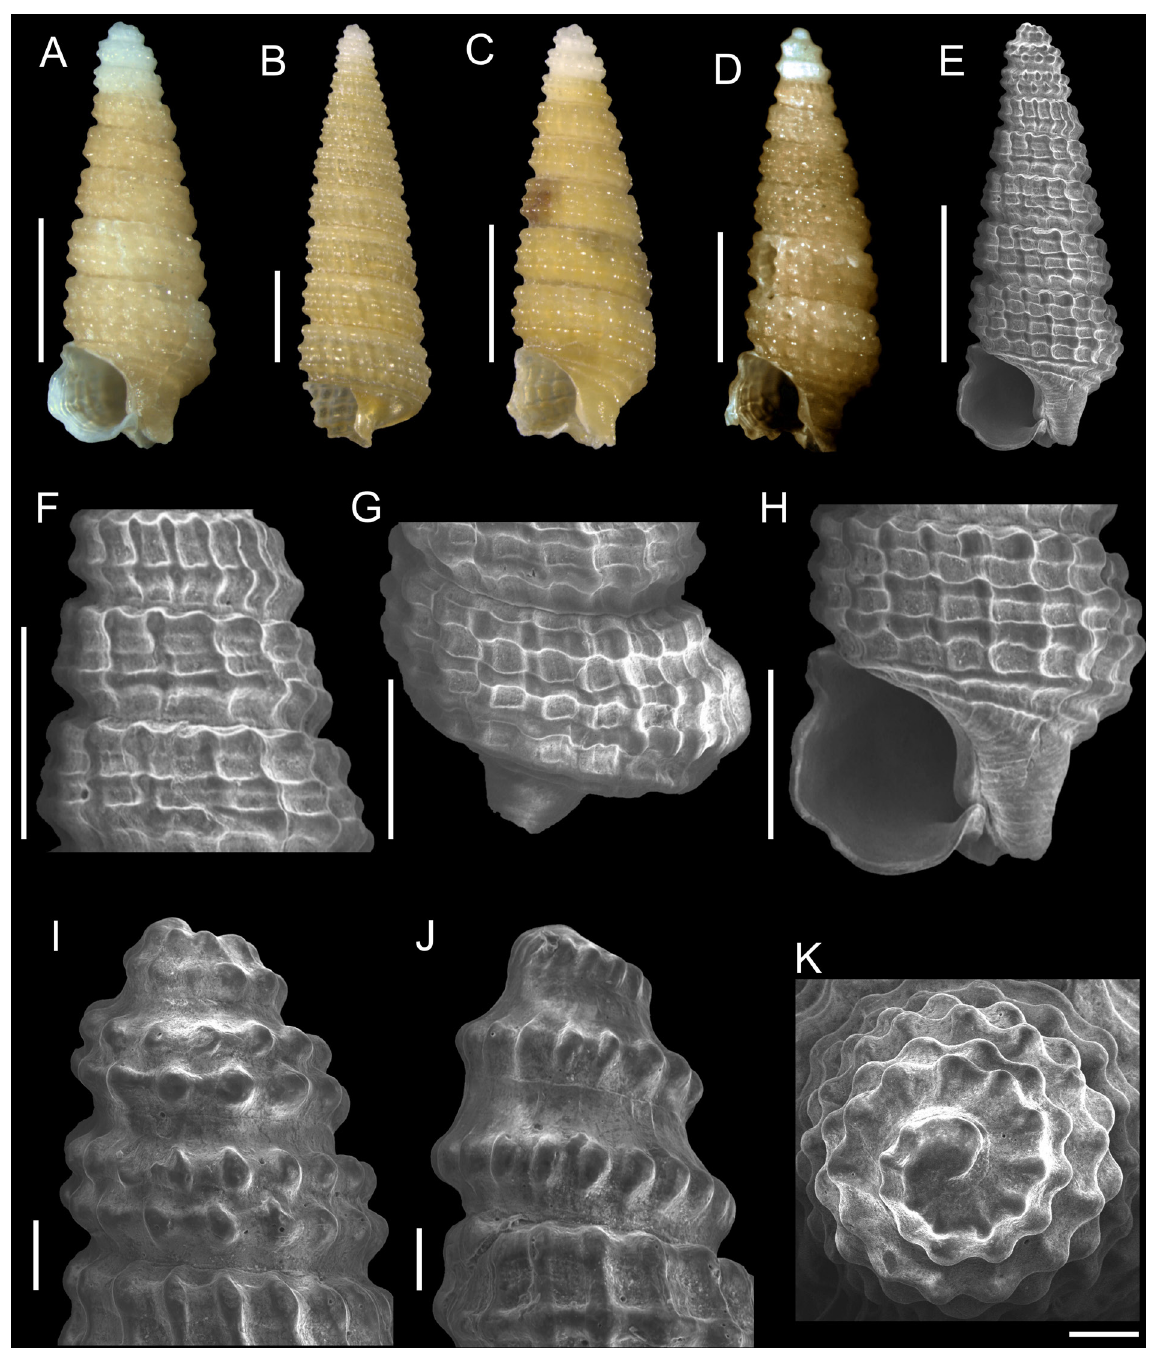
Fig. 3. Isotriphora tricingulata Rolán & Fernández-Garcés, 2015. A, C . MNRJ 32558*, 2.75 mm and 3.04 mm, respectively. B . MNRJ 17929*, 4.62 mm. D . MNRJ 32574*, 3.29 mm. E–I, K . Same shell as A. J . Same shell as D. Scale bars: A–E = 1 mm; F–H = 500 µm; I–K = 100